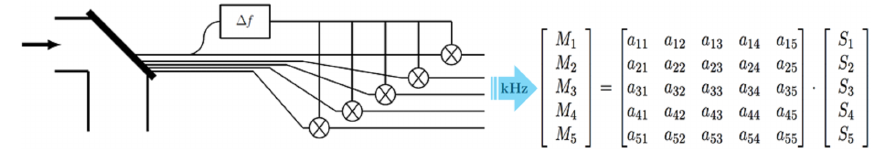
Figure 9. Schematic for the analysis of individual coupler signals